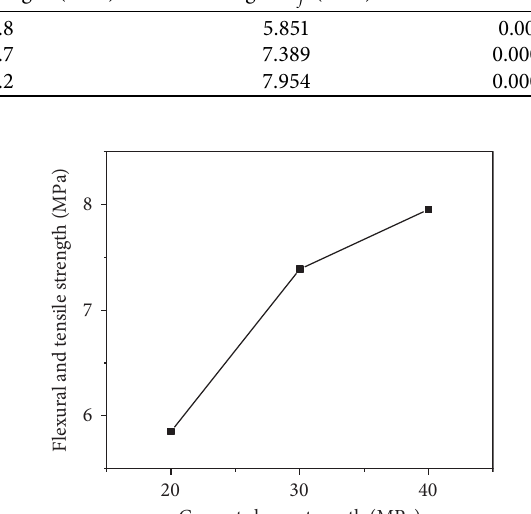
Figure 18: Variation curve of fexural and tensile strength with the cement slurry strength at − 15 °